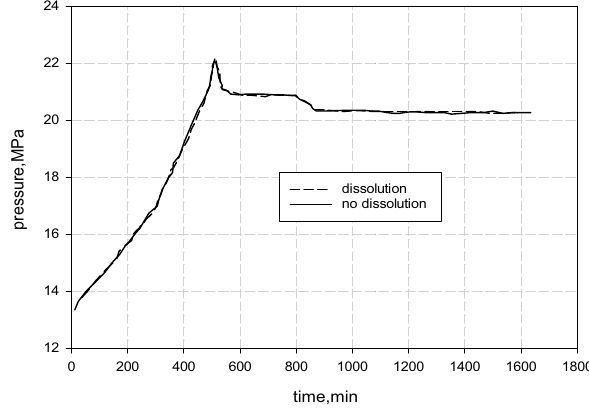
Fig. 16 Injection pressure curve contrasting dissolution and no disso- lution (experiment 2)